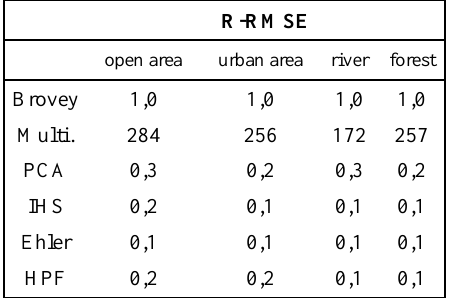
Table 2. R-RMSE indicators of the pan-sharpened images